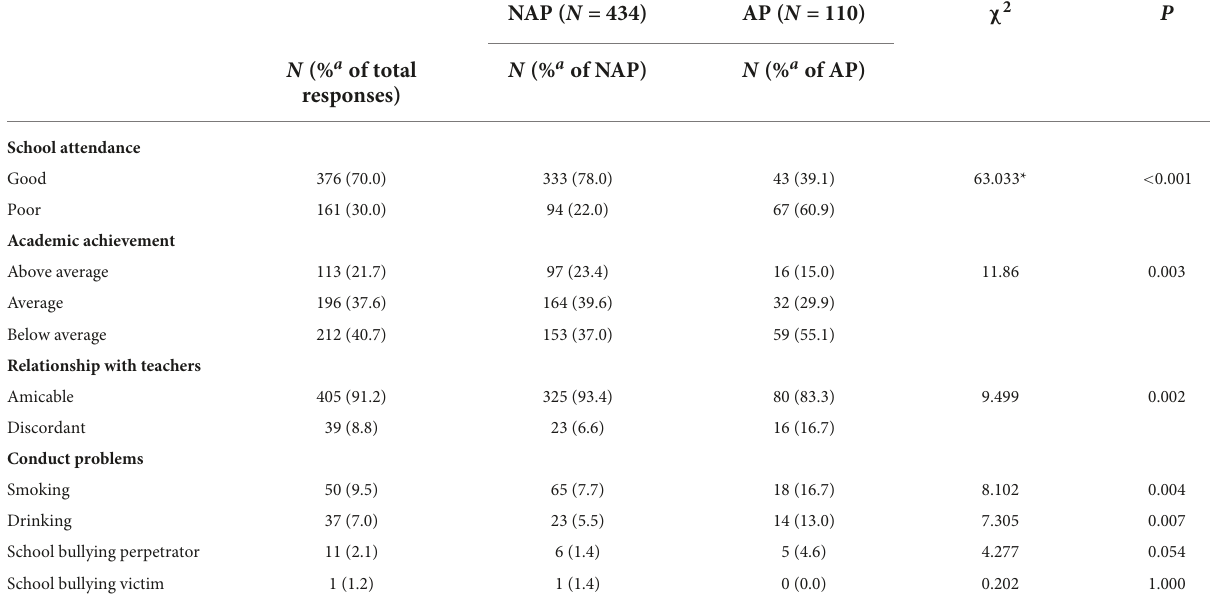
TABLE 4 School-related